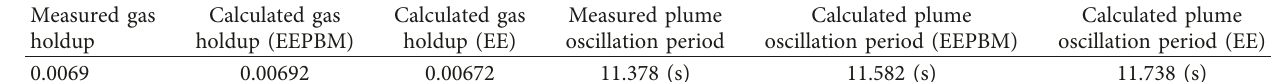
Table 3: Comparison between experimental and calculated results.